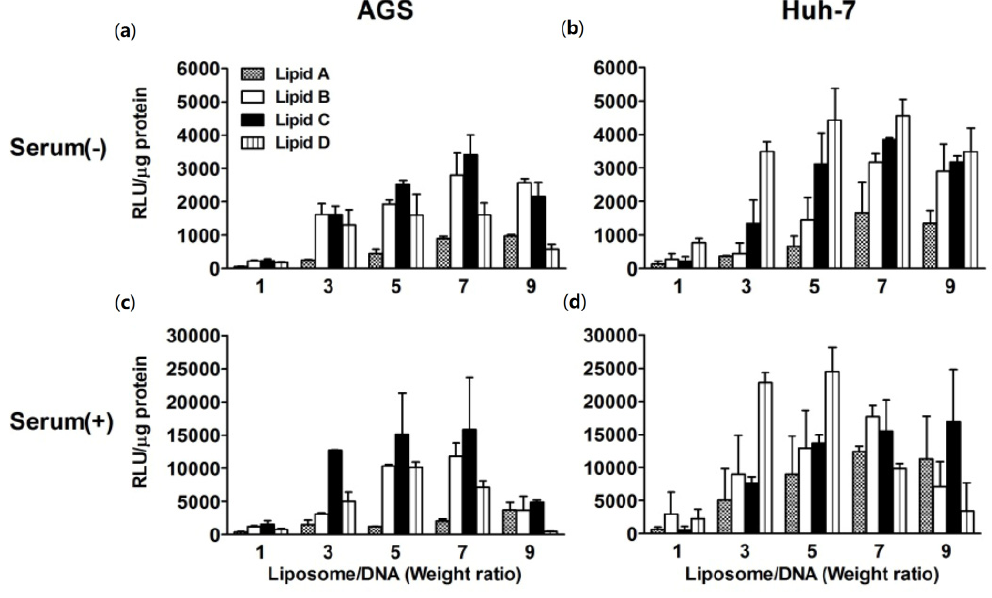
Figure 3. In vitro transfection efficiencies of liposomes A – D at different liposome:DNA weight ratios. In vitro transfection efficiencies of liposomes A – D in AGS ( a , c ) and Huh-7 ( b , d ) cells at optimized lipid:DOPE weight ratios (cationic lipids only for liposome A , 3:1 for liposome B , and 1:1 for liposome C and D ) when using DOPE as a co-lipid. The incubations were performed in the presence ( c , d ) or absence ( a , b ) of serum. The x -axes show cationic liposome/DNA weight ratios while the concentration of DNA (0.2 μ g/well) was kept constant. Bars represent the mean ± SD of experiments performed in